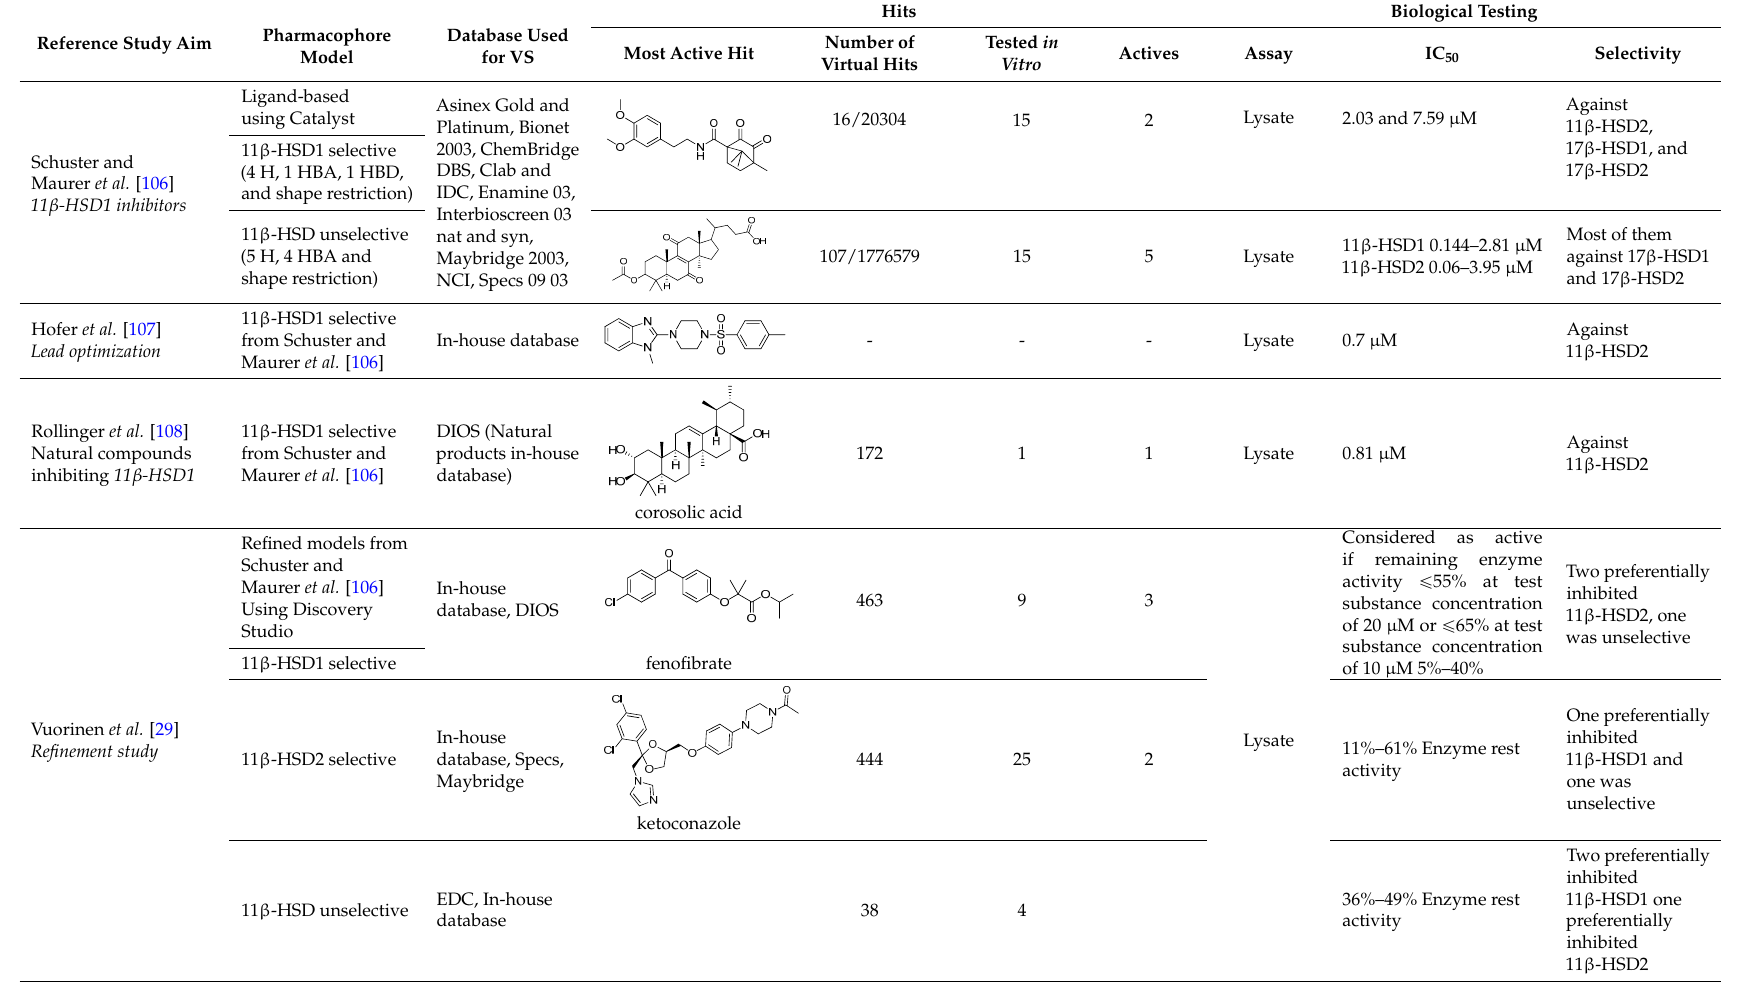
Table 1. 11 β -HSD1 pharmacophore-based virtual screening studies summarized.